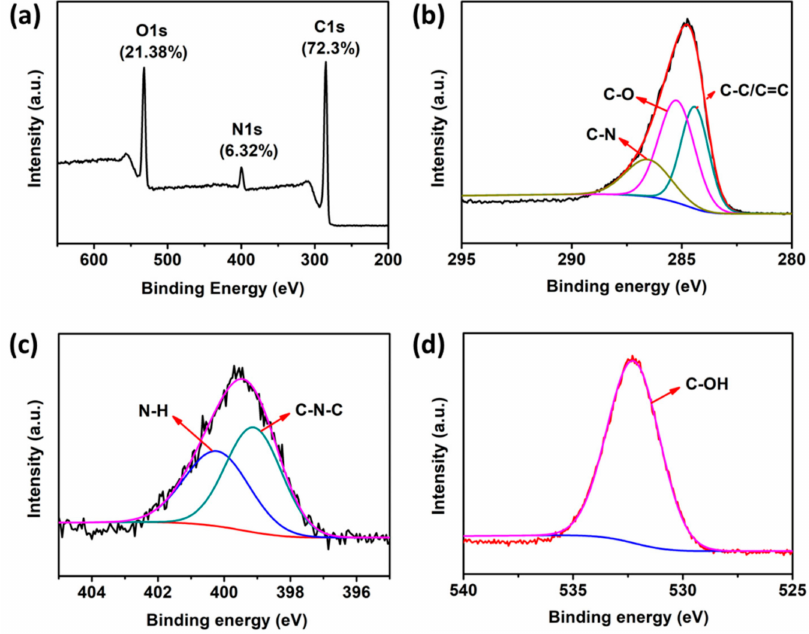
Figure 3. ( a ) X-ray photoelectron spectroscopy (XPS) spectra of N-CQDs. ( b – d ) High-resolution XPS spectra of (b) C1s, (c) N1s, and (d)